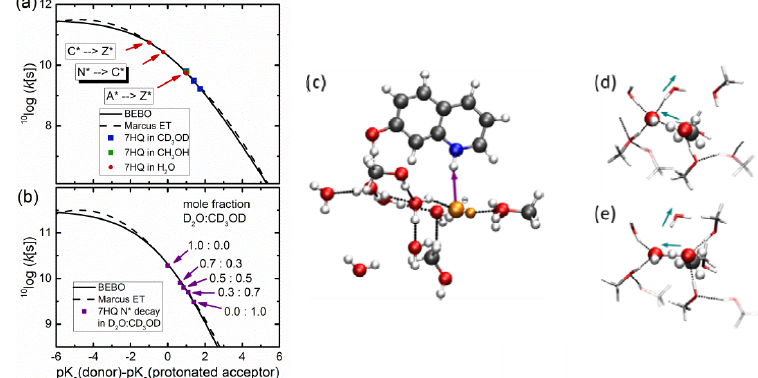
Fig. 2. (a) Free‐energy reactivity relationship for different proton transfer steps of 7HQ in H 2 O, CH 3 OH and CD 3 OD. (b) Free‐energy reactivity relationship of 7HQ in D 2 O:CD 3 OD mixtures. (c) Snapshot of a QM/MM MD simulation of 7HQ showing the first step in the CH 3 O ‐ ‐transport mechanism along a methanol bridge. (d) Four‐fold hydrogen‐bonded OH ‐ before transfer event. (e) Three‐fold OH ‐ in the transfer transition state. Arrows illustrate movement of the water molecule whose hydrogen bond breaks in the course of the transfer and the movement of the transferred proton,